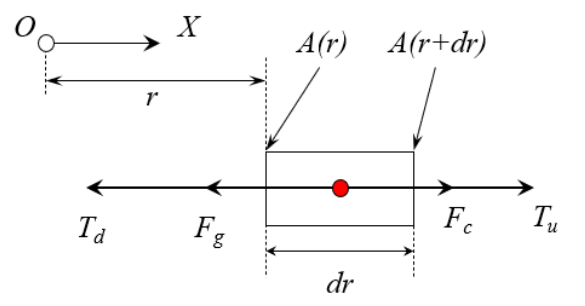
Figure 5. Force analysis of the rope